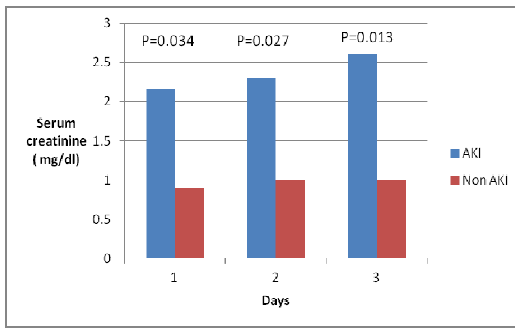
Figure 2: Course of serum creatinine levels in postoperative period in AKI and non AKI